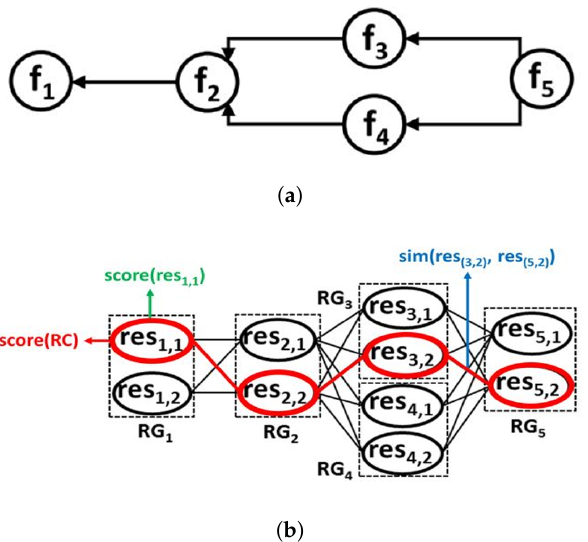
Figure 5. An example of a DRAG showing the scores defined for a possible composition, each of the involved resources and their I/O matching. ( a ) A workflow model example; ( b ) The corresponding DRAG